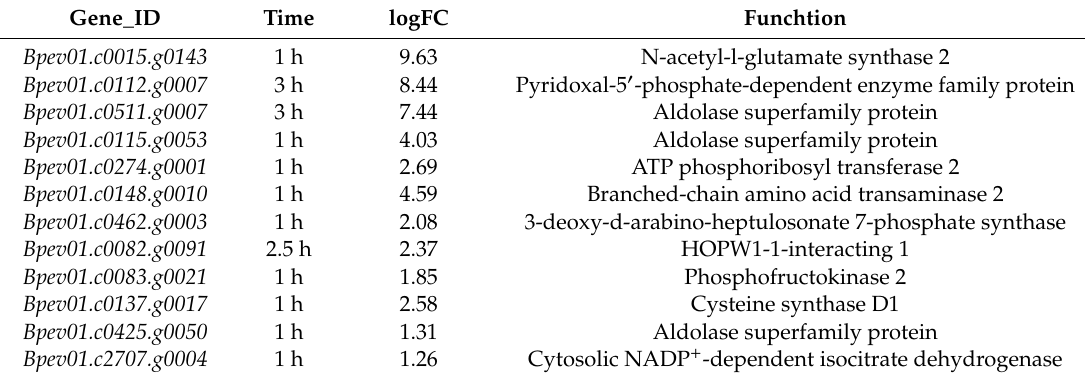
Table A8. Amino acids biosynthesis-related DEGs under low-temperature stress in